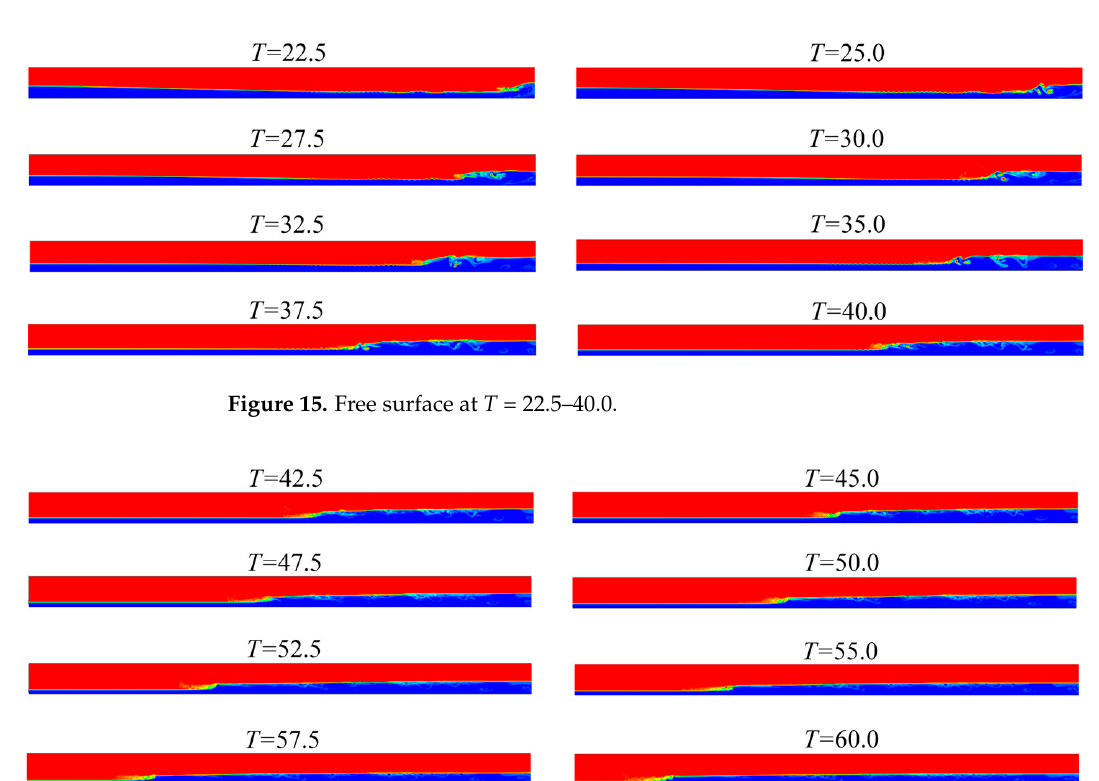
Figure 14. Free surface at T = 2.5~20.0.